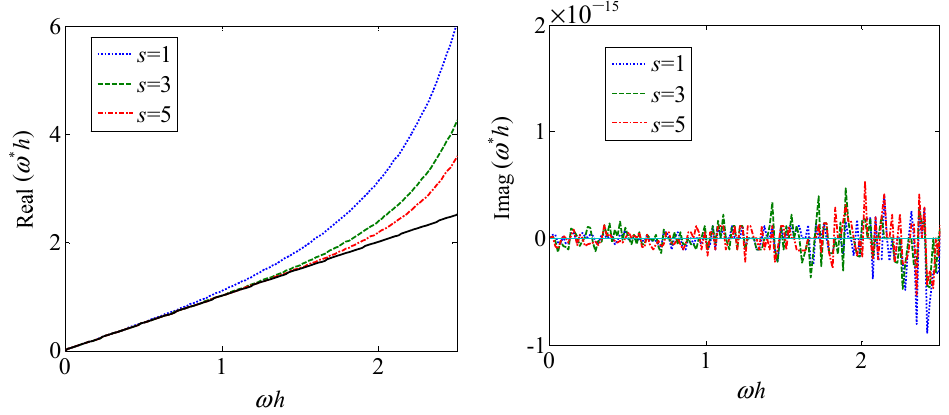
Figure 6. Plot of real and imaginary parts of the modified wavenumber for ETR 1 .